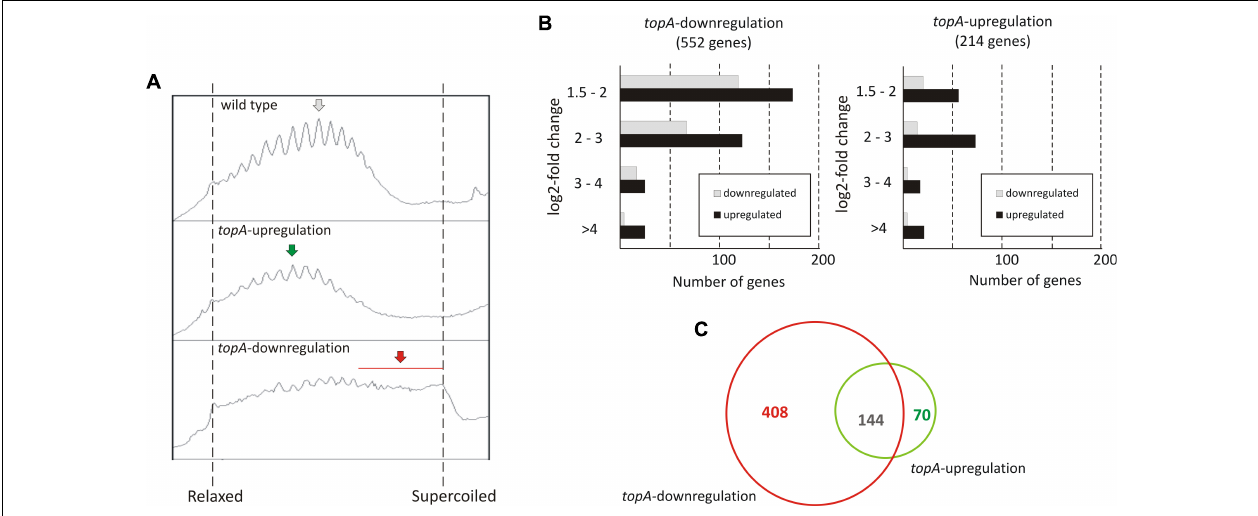
FIGURE 2 | The transcriptional response to long-term supercoiling imbalance. (A) The supercoiling density analysis of the reporter plasmid isolated from the wild type strain (upper panel), the topA -upregulated strain (middle panel), and the topA -downregulated strain (lower panel). The most abundant topoisomers under each condition are marked with arrows. (B) Differentially regulated genes identified using RNA-Seq following topA -downregulation (left) and topA -upregulation (right). The up- (black) or downregulated (gray) genes were grouped according to the magnitude of their transcriptional changes compared to the wild type strain (log2-fold change value). (C) Comparison of the number of genes specifically affected by topA -upregulation and topA -downregulation, and those common to both